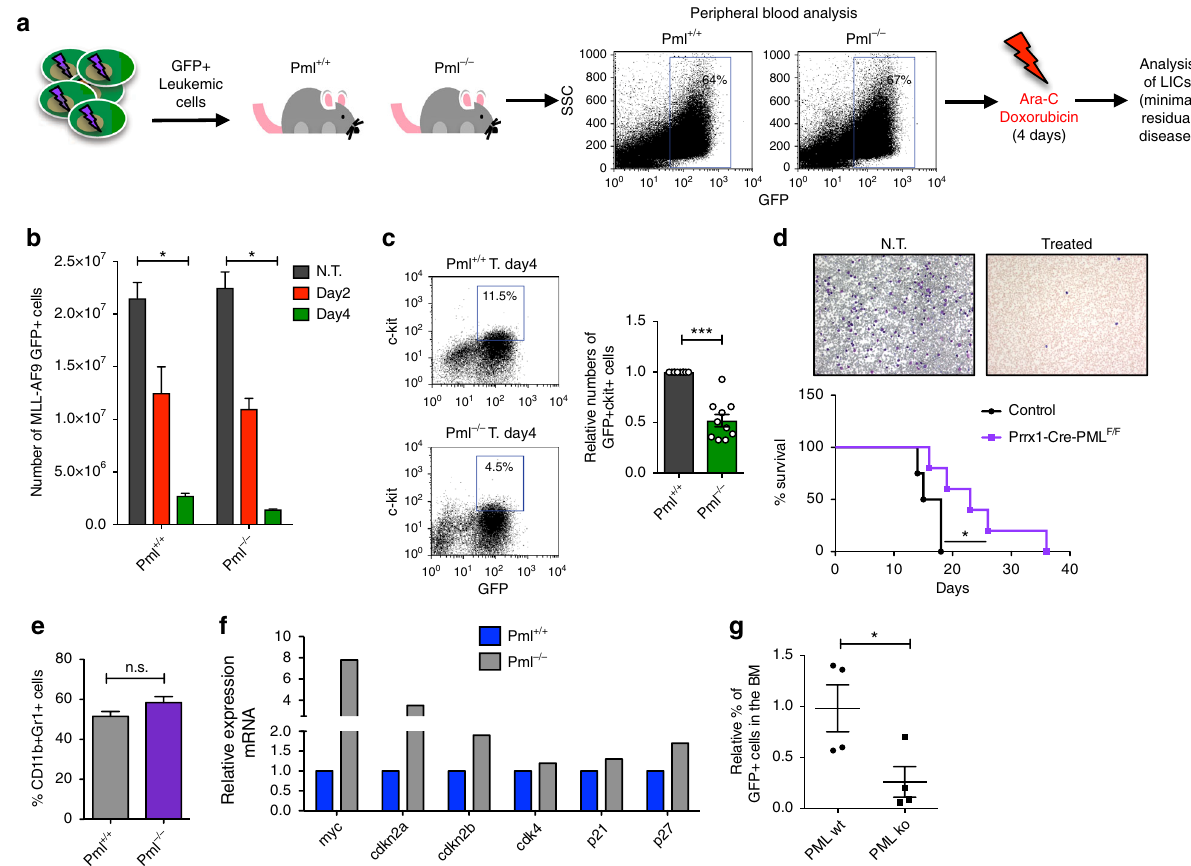
Fig. 4 Pml sustains non-cell autonomously minimal residual disease in AML upon chemotherapy treatment. a Schematic overview of the experimental design for the treatment of Pml +/+ or Pml − / − mice with chemotherapeutic drugs. b Progressive reduction of leukemic cells upon chemotherapy in treated Pml +/+ or Pml − / − mice; n = 2 mice for each condition. Charts show average ± SEM. c Progressive reduction of percentages (plot on the left) and numbers (chart on the right) of MLL – AF9 + GFP + ckit + cells collected from the endosteal bone marrow of Pml +/+ or Pml − / − mice treated for 4 days with AraC and doxorubicin ( n = 10 mice each group analyzed). Charts show the average ± SEM. d Survival curve of Prrx1-Cre-Pml F/F or control mice that carry MLL/AF9 leukemic cells, and which have been treated with chemotherapy (AraC+Doxorubicin) for 4 days. Leukemic blasts in the blood of treated or not treated mice are shown in the upper panel. e Percentage of leukemic cells derived from Pml +/+ or Pml − / − mice treated with chemotherapy, which express the surface markers CD11b and Gr1; n ≥ 5 mice each group. f Relative expression of myc, cdkn2a, cdkn2b, cdk4, p21, and p27 in LICs derived from Pml +/+ or Pml − / − mice after treatment with chemotherapy (cells of n = 4 mice each group have been pooled before RNA extraction). g Percentage of GFP + leukemic cells in secondary recipient mice transplanted with residual leukemic cells derived from Pml +/+ or Pml − / − mice treated with chemotherapy ( n = 4 mice each group). Data are shown as average ±